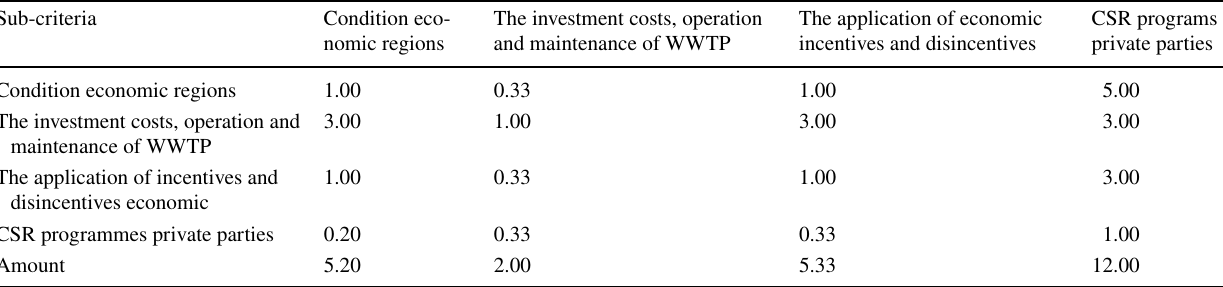
Table 11 Matrix comparison of sub-criteria Sub-criteria